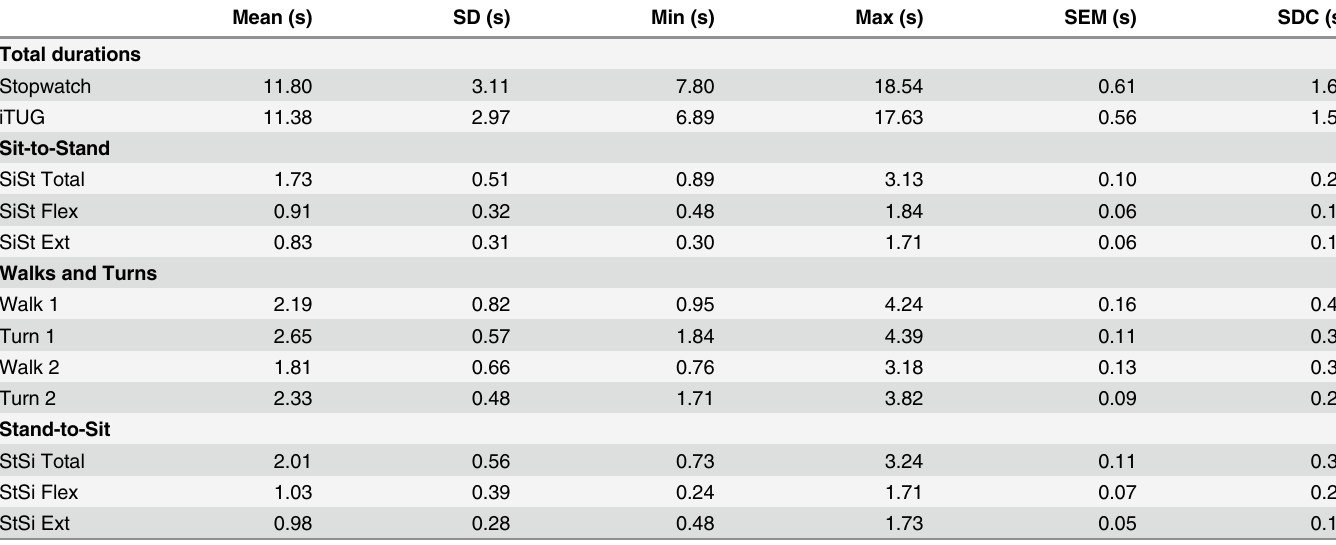
Table 2. Mean, Standard deviation, Minimum, Maximum, Standard Error of Measurement and Smallest Detectable Change of the total time of the stopwatch, total time of the iTUG and individual components of the iTUG in